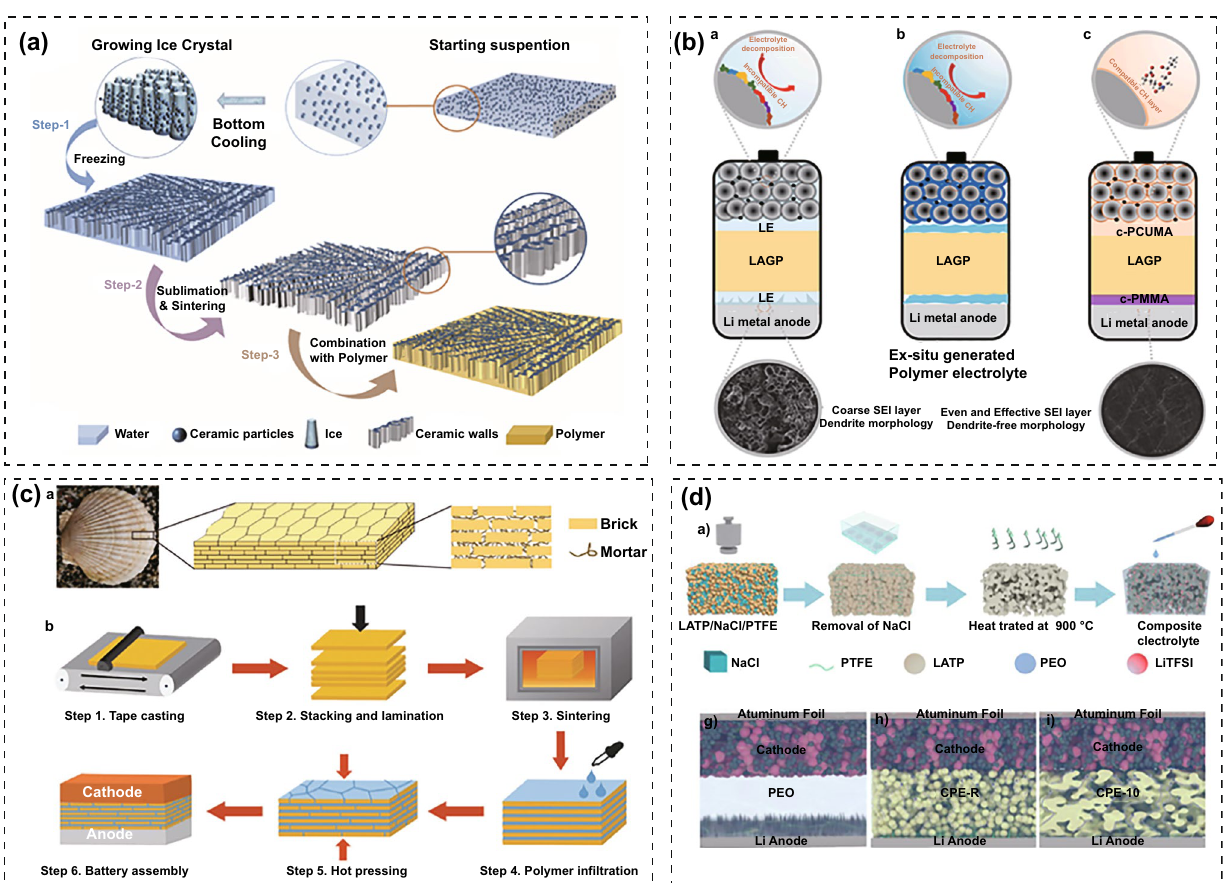
Fig. 11 a Schematic of constructing a vertically aligned PIEs with LAGP and flexible PEO/PEG polymer [181]. Copyright 2019, Elsevier. b Comparison of interfacial evolution in a liquid electrolyte, ex situ polymer modification and in situ Janus polymer modification [196]. Copyright 2022, Elsevier. c Preparation process of PEO-LiTFSI@LAGP PIEs with “brick–mortar” microstructures [182]. Copyright 2020, John Wiley and Sons. d Illustration for the preparation of porous interconnected LATP networks with NaCl as a sacrificial template and SEM images of the